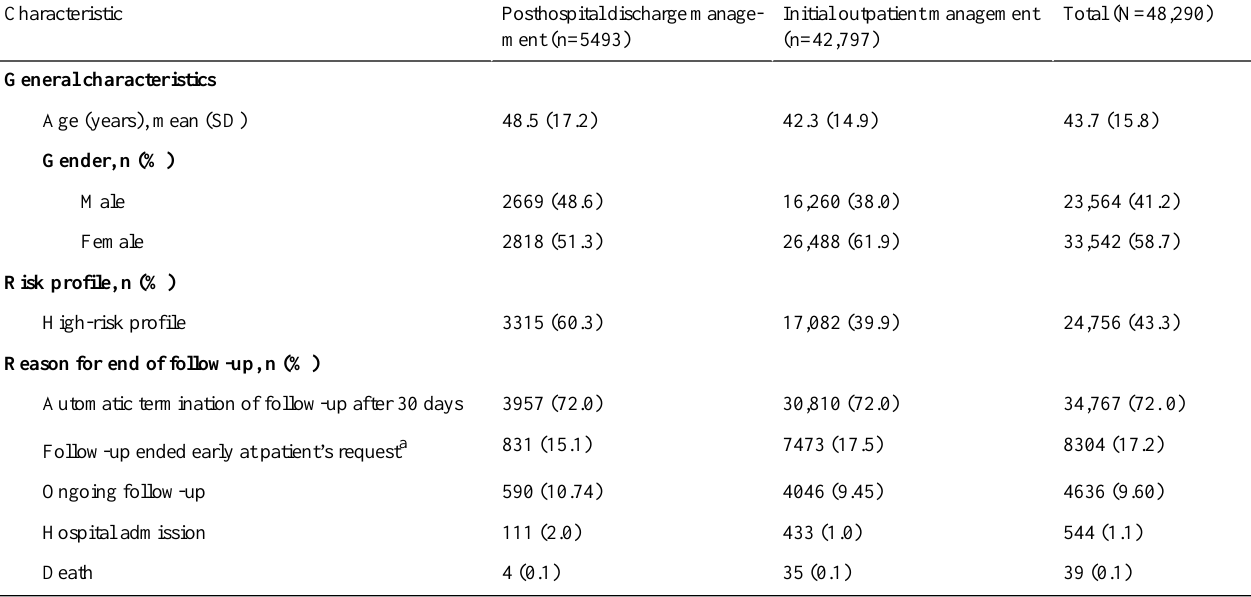
Table 1. General characteristics of and reasons for end of follow-up among patients using Covidom, as of May 19, 2020.